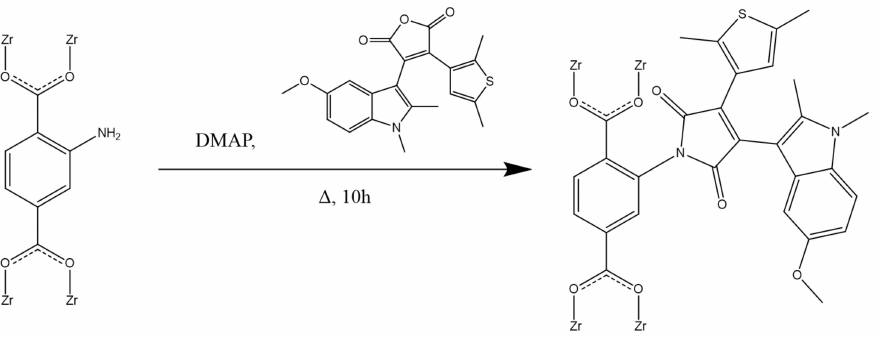
Figure 2. Scheme of UiO-66-NH 2